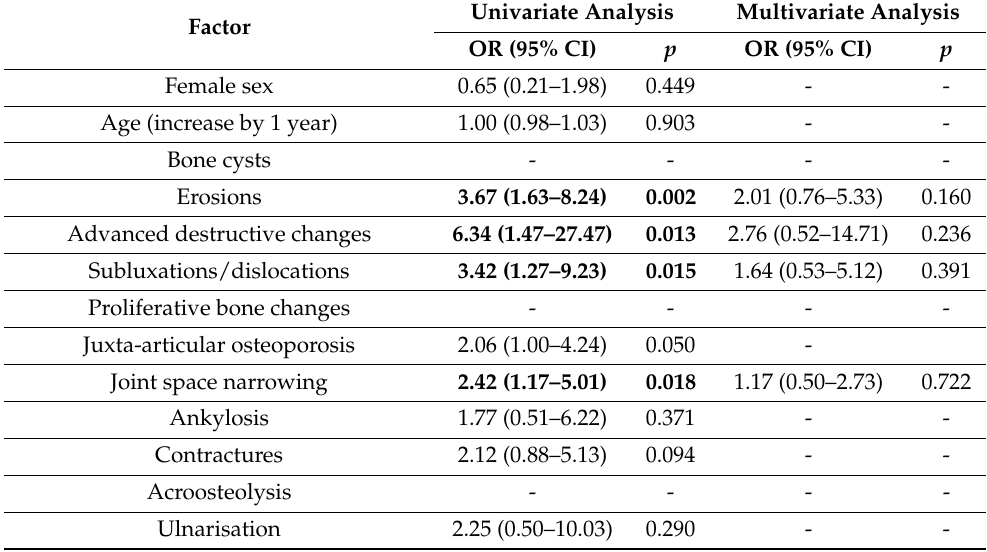
Table 10. Logistic regression for the dependent variable of seropositive RA vs. the independent variable of seronegative RA considering the types of